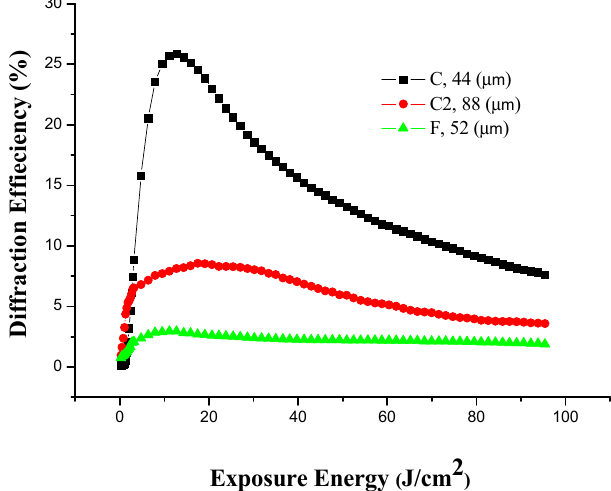
Figure 7. Diffraction efficiency for samples C, C2, and F with different thickness.